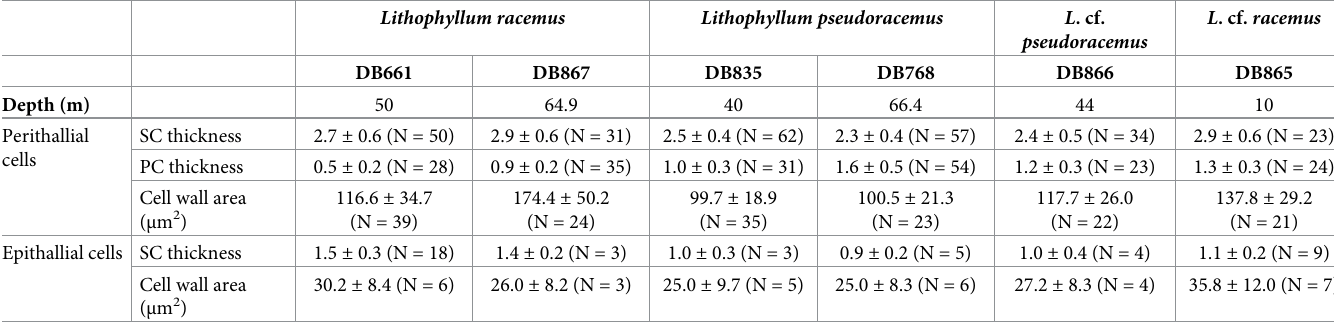
Table 3. Mean values ( ± SD) of calcification traits from SEM images ( μ m, otherwise differently